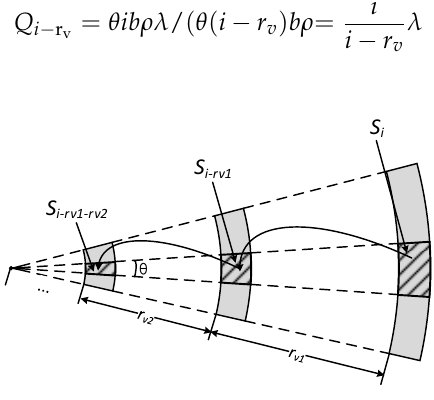
Figure 17. Process of data collection.